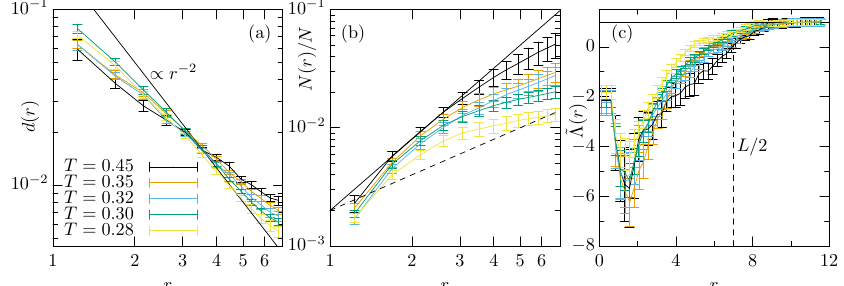
Figure 13: (a) Decay profile, (b) N ( r ) / N , and (c) energy profile for the QLVs of IS. The solid line in (a) is proportional to r − 2 . The dashed and solid lines in (b) show the power laws with the fractal dimensions D = 1 and 2, respectively. The dashed vertical line in (c) shows half of the box length L / 2.